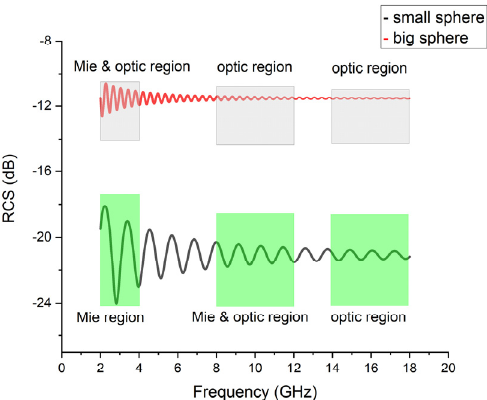
Figure 3. Theoretic RCS values of the two spheres in the radar bands (2~18 GHz).